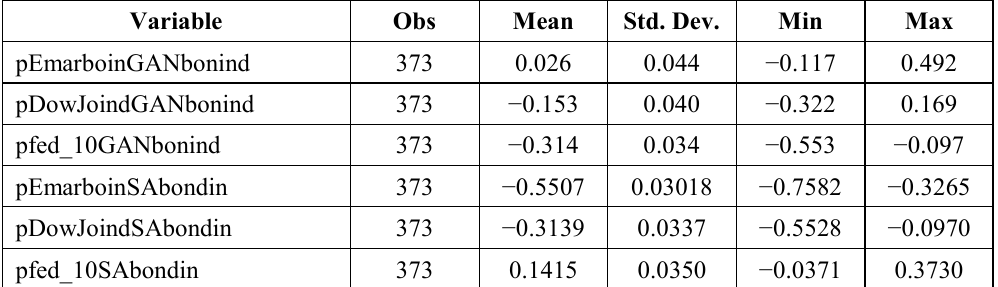
Table 3. Descriptive Statistics of Dynamic Conditional